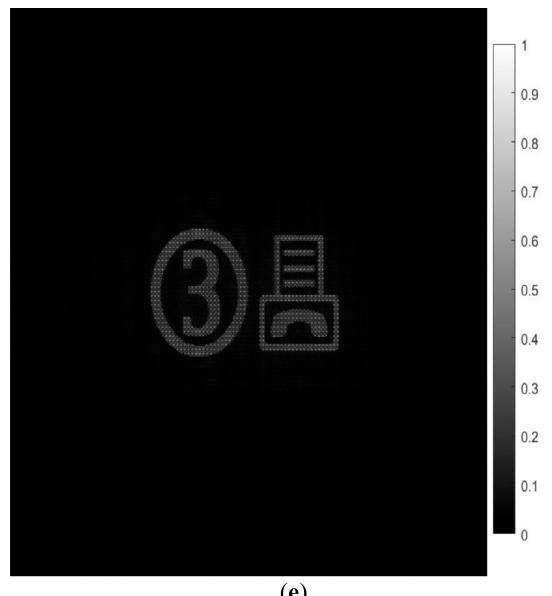
Figure 2. ( a ) Source image, ( b ) reconstructed image with the phase component of the hologram of the source image, mostly invisible with most of the contents removed but with slight edge information, ( c – e ) reconstructed images of the sampled phase-only hologram (SPOH) of the source image with down-sampling factor τ = 8, 12, and 16, respectively. Appl. Sci. 2020 , 10 , x FOR PEER REVIEW